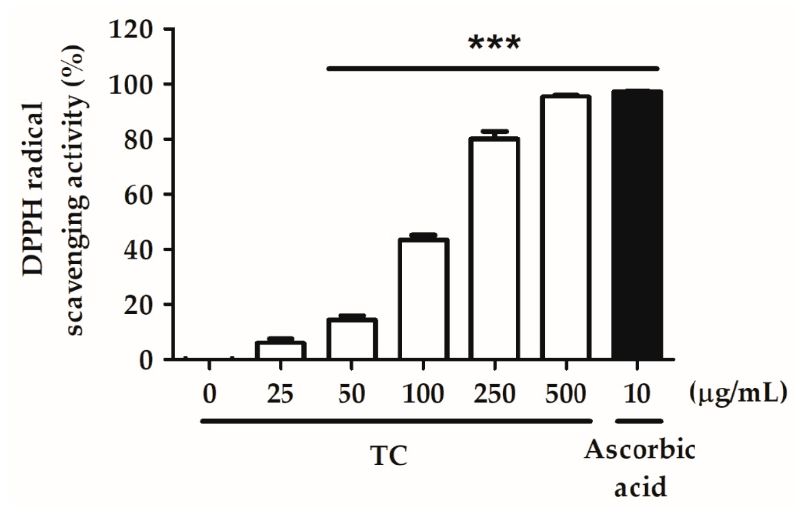
Figure 2. TC scavenges the DPPH radical in a dose-dependent manner. TC exhibited a dose-dependent DPPH radical scavenging ability, with an EC 50 value of 205.7 µg/mL. Ascorbic acid was used as a positive control. Significant differences between the treated groups and the negative control were evaluated. *** p < 0.001 compared to the control group.